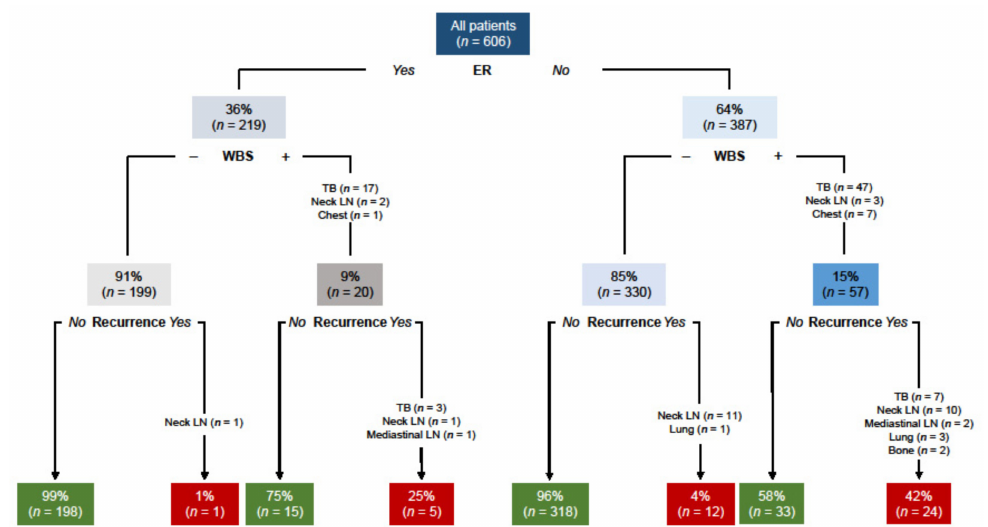
Figure 3. Outcome of patients according to 12-months response to therapy and diagnostic WBS findings. ER (excellent response), WBS (whole body scan), TB (thyroid bed), LN (lymph nodes).